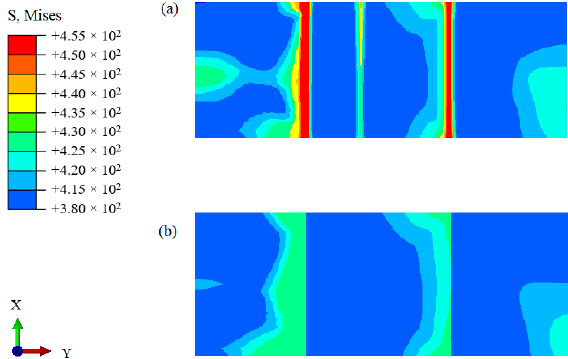
Figure 6. Numerical simulation results under an axial load: ( a ) continuous transition model, ( b ) sandwich model.